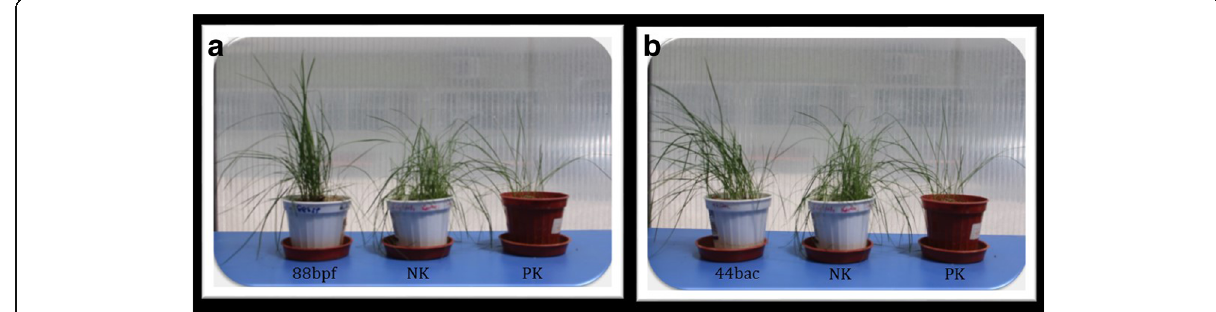
Fig. 3 Effect of some bacterial isolates against southern blight caused by Sclerotium rolfsii in greenhouse experiments. a Stenotrophomonas rhizophila 88bpf, b Bacillus cereus 44bac (NK uninoculated plants, PK pathogen-inoculated plants)